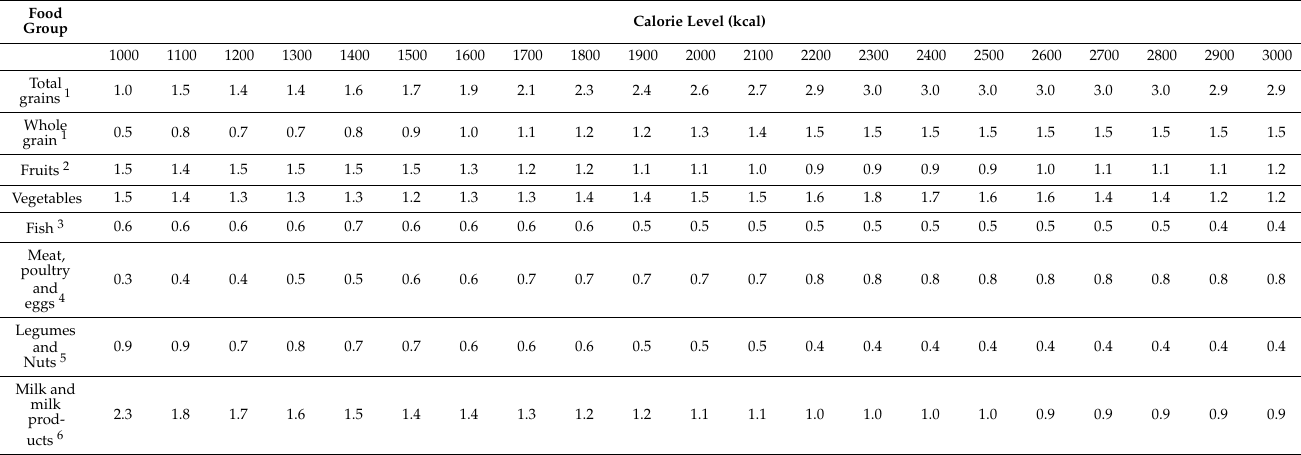
Table 2. Recommended servings according to food group (adequacy component), expressed per 1000